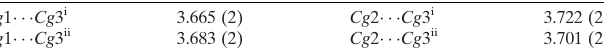
Table 2 (cid:3) – (cid:3) interactions (A˚